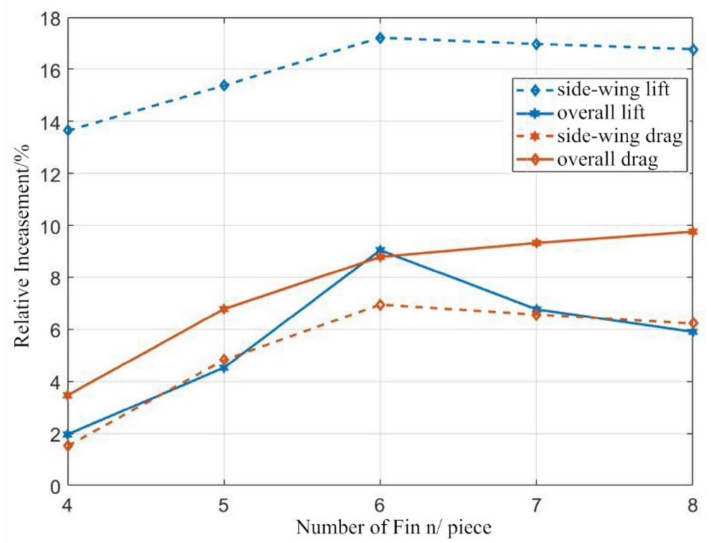
Figure 19. Gross height of shutters and its influence on side wing aerodynamic performance.